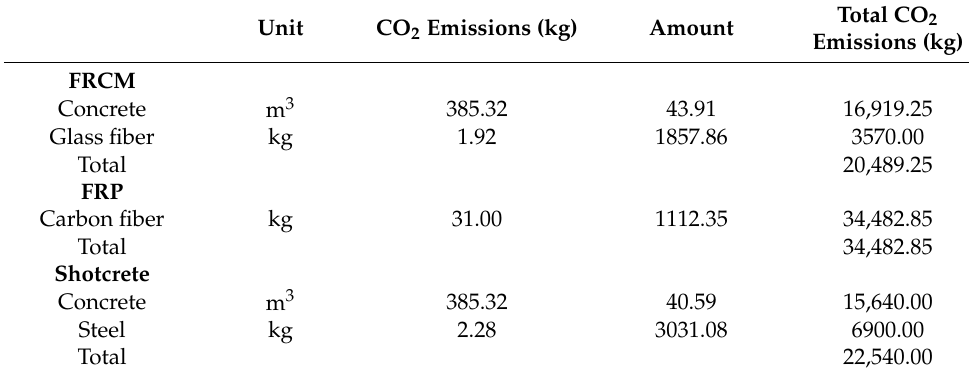
Table 13. CO 2 emissions for different